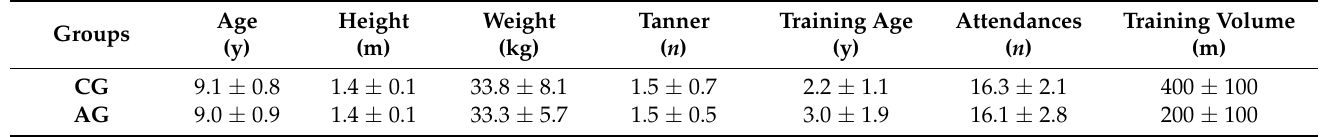
Table 1. Swimmers’ anthropometrics and intervention